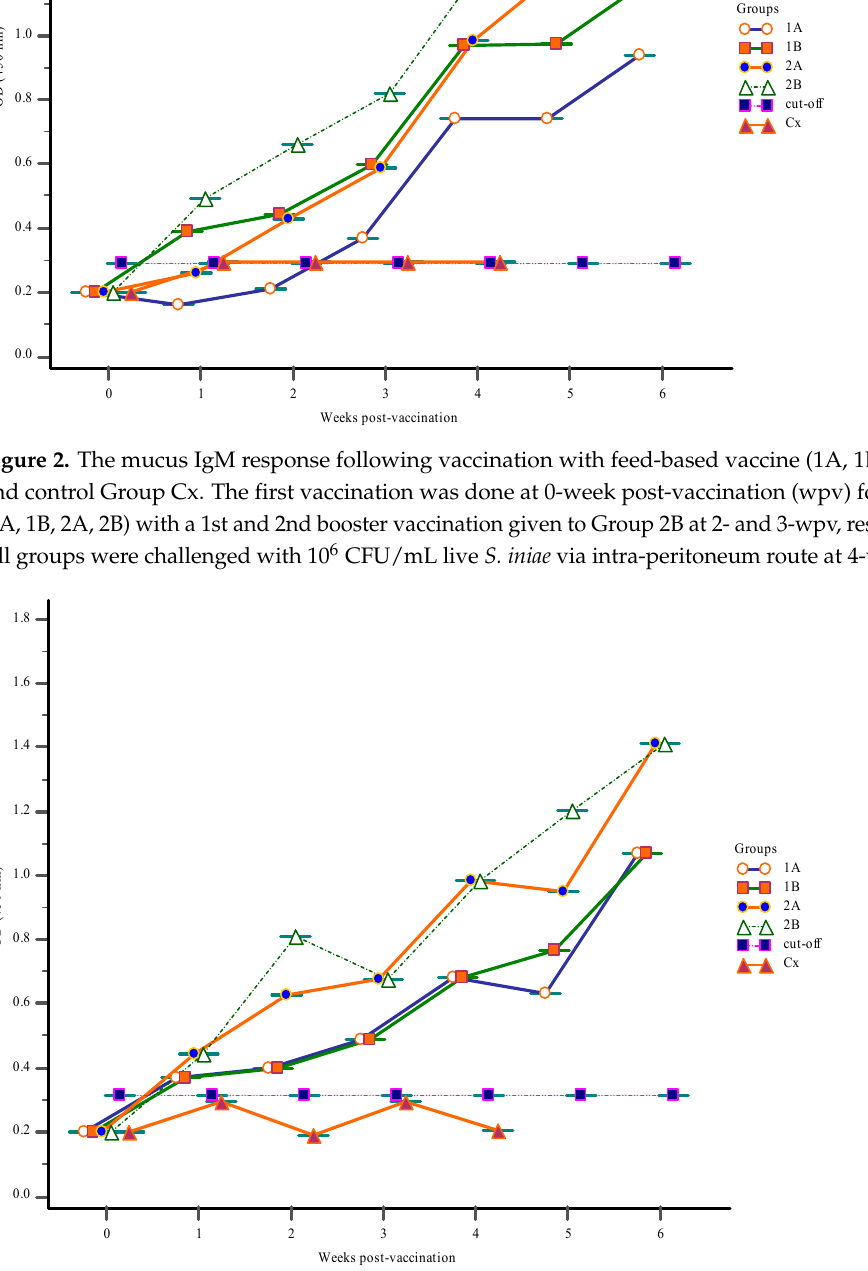
Figure 3. The gut-lavage fluid IgM response following vaccination with feed-based vaccine (1A, 1B, 2A, 2B) and control Group Cx. The first vaccination was done at 0-week post-vaccination (wpv) for groups (1A, 1B, 2A, 2B) with a 1st and 2nd booster vaccination given to Group 2B at 2- and 3-wpv, respectively. All groups were challenged with 10 6 CFU/mL live S. iniae via intra-peritoneum route at 4-wpv.